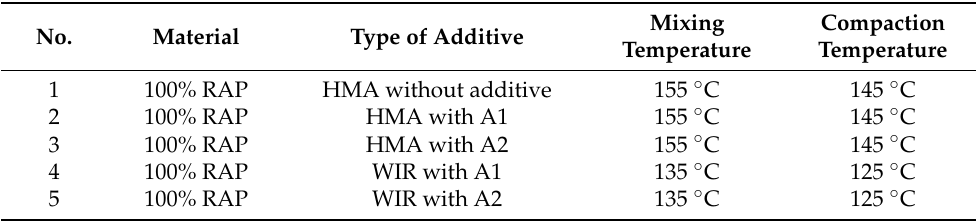
Table 2. Mixing and compaction temperatures for each mix type.